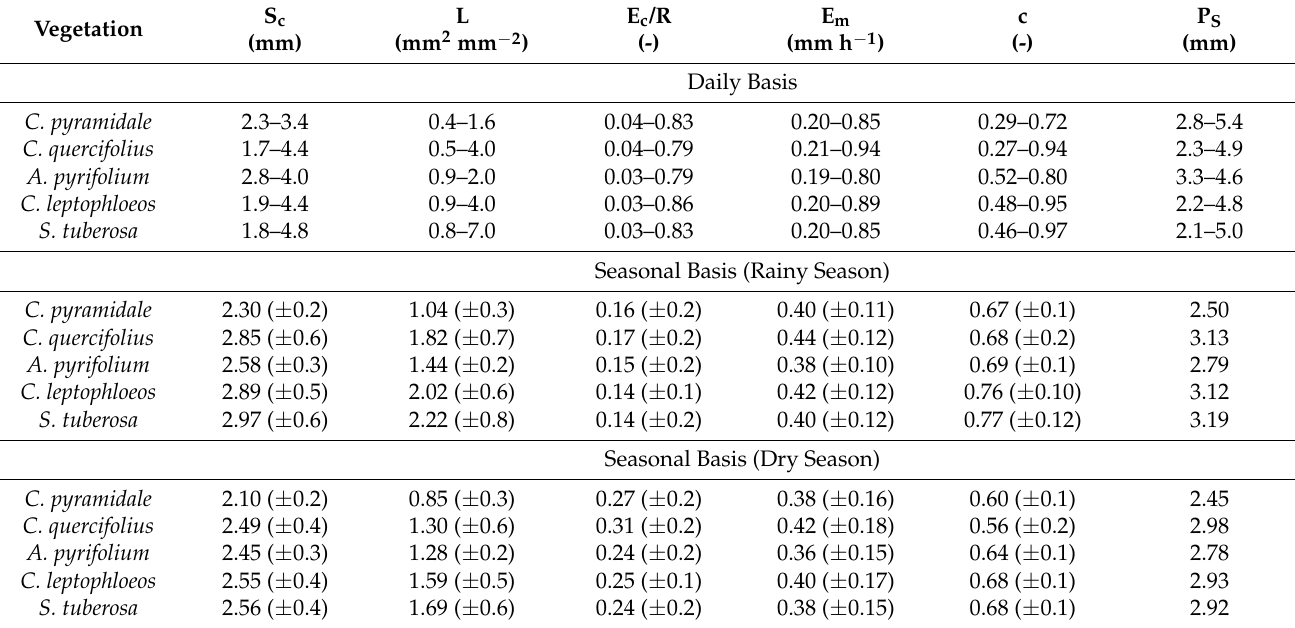
Table 5. Measured leaf area indices (L) and estimated canopy storage capacity per unit area of cover (S c ), relative evaporation rate per unit area of cover (E c /R), evaporation rate from wet canopy (mm h − 1 ), canopy cover fraction (c) and threshold value required to saturate the canopy (P S ) for the sparse Gash model parametrized on daily and seasonal bases applied to each studied Caatinga species. Values in brackets represent standard